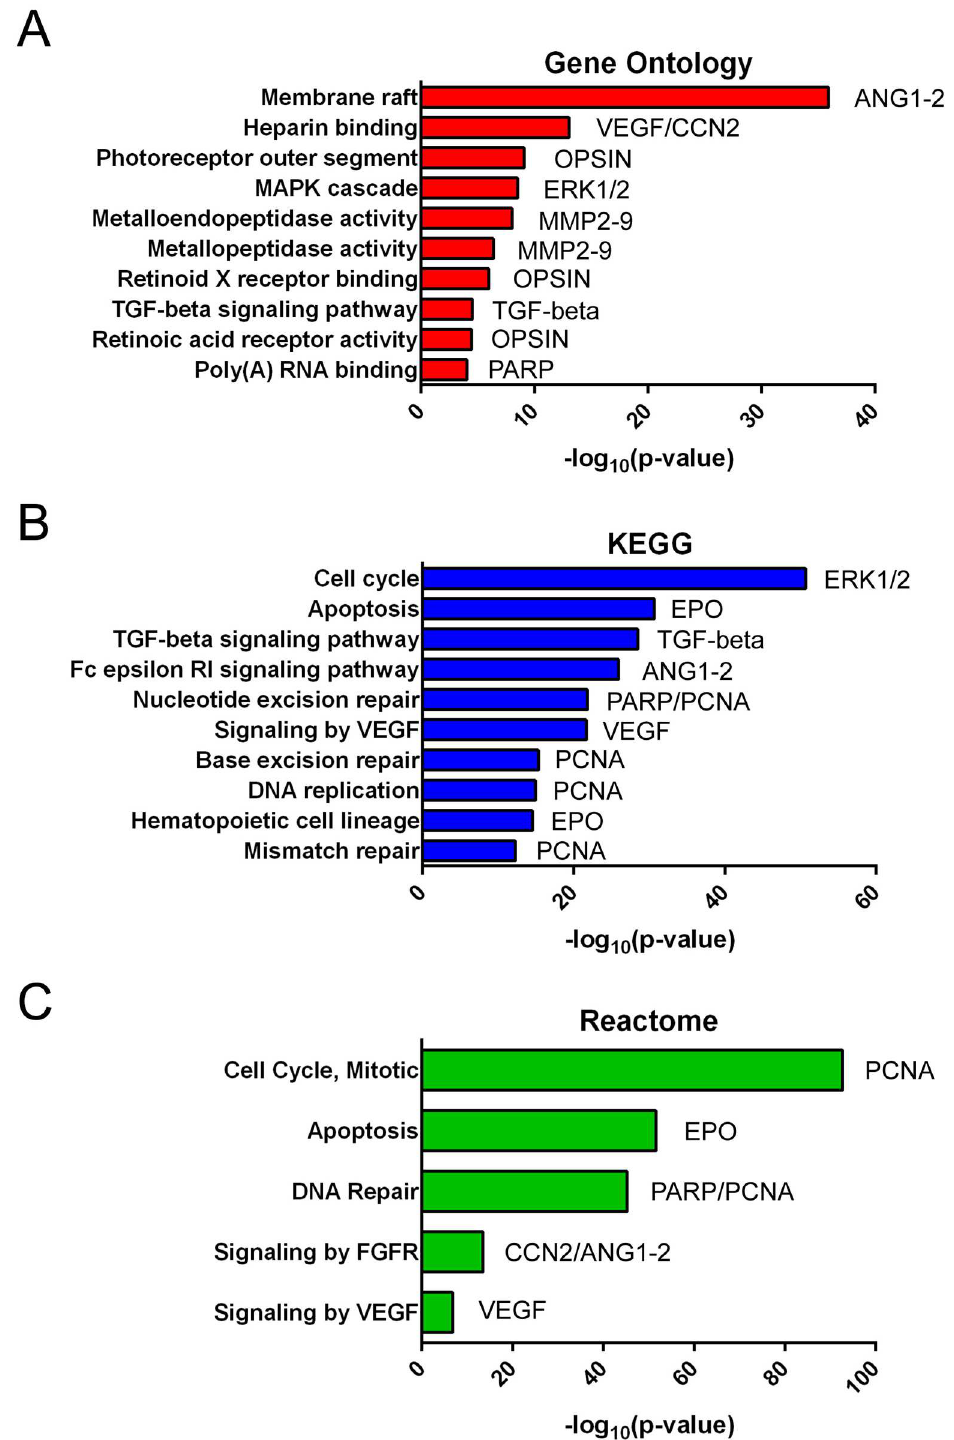
Fig 2. Biological processescontrolled by miR-19b, miR-24 and miR-142-3pnetwork. Overrepresented biological functions from a molecularnetwork built on validatedtargets of differentially expressedmiRNAs, retrieved from different annotation databases(GO, KEGG, Reactome). On the left of each histogram the overrepresented pathwaysare reported,while on the right the corresponding associatedgenesto MHs and ERMs based on literaturedata are shown. Data are plotted as—log10 of p-valuesfor each biological process.